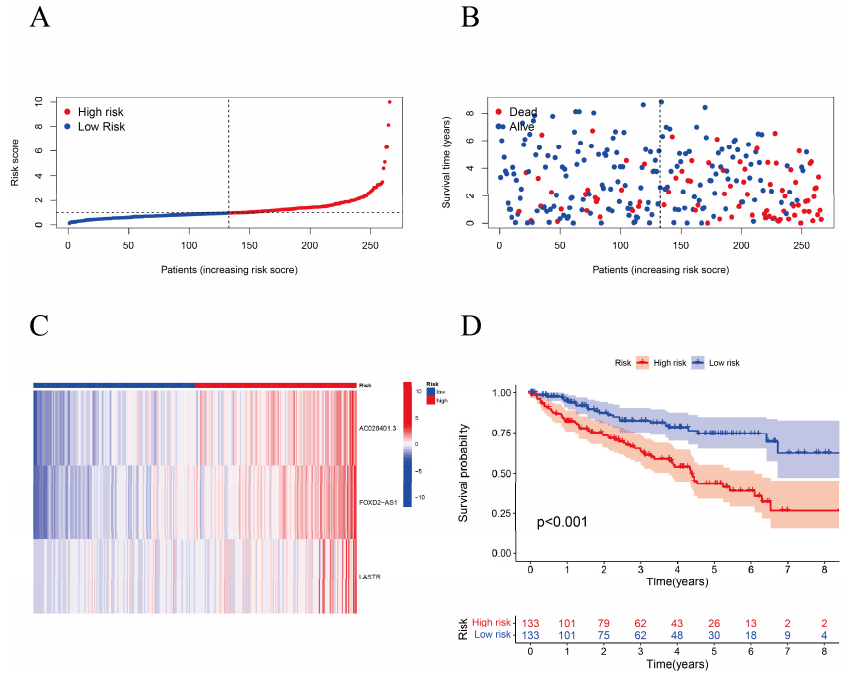
Figure 6. Development of a CRLR risk model in ccRCC. ( A ) The distribution of the risk grades between the low- and high-risk groups. ( B ) The survival statistics and survival times of the patients in the two risk groups. ( C ) The relative expression standards for the three CRLRs. ( D ) K–M survival curves of ccRCC in the low-risk group and the high-risk group ( p < 0.001).